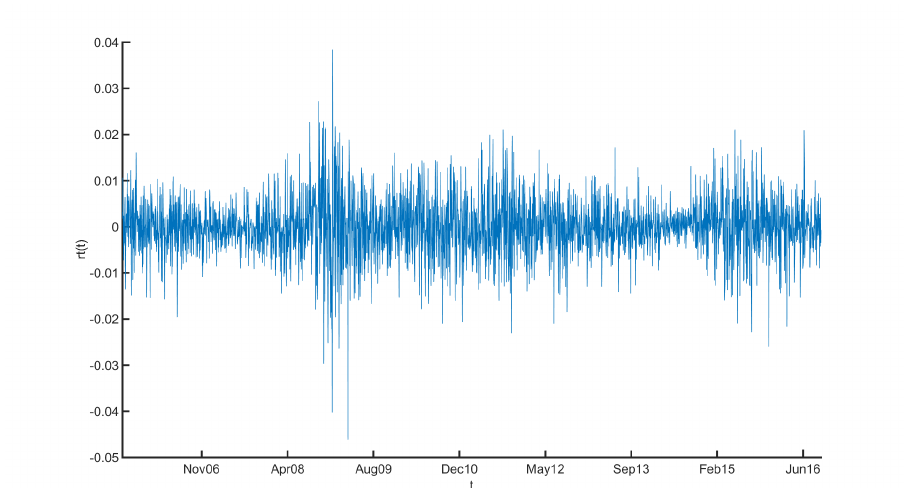
Figure 1. Log-returns of the EURUSD exchange rate from 16 August 2005–30 September